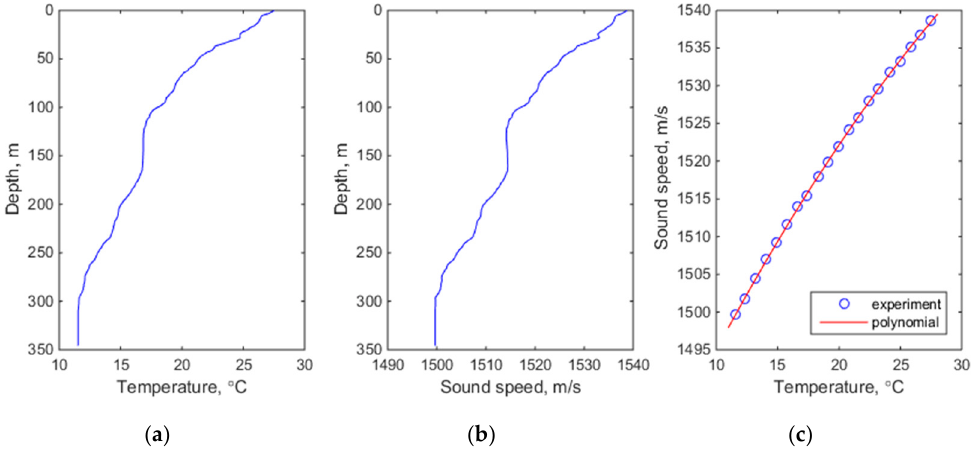
Figure 6. The unperturbed temperature profile ( a ), the SSP ( b ), obtained using the ship’s CTD probe, and the dependence of the speed of sound on temperature ( c ) constructed on their